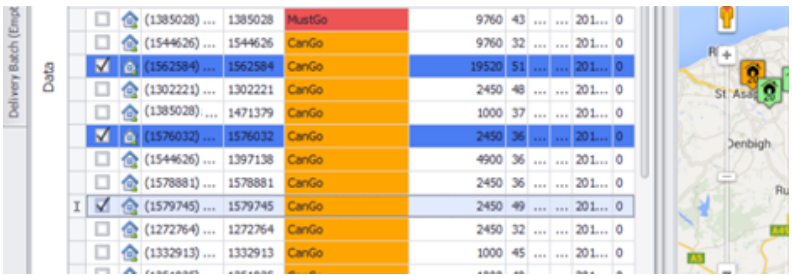
Figure 8. An exemplary fragment of the operator’s application window containing decisions about sending a tanker to the